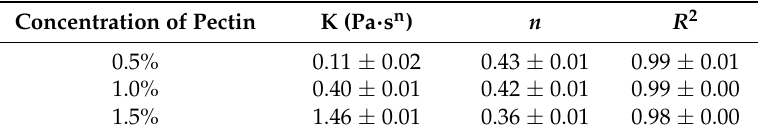
Figure 1. Rheological curves of pectin at different concentrations. Table 1. Parameters of pectin flow curves obtained by fitting to power law